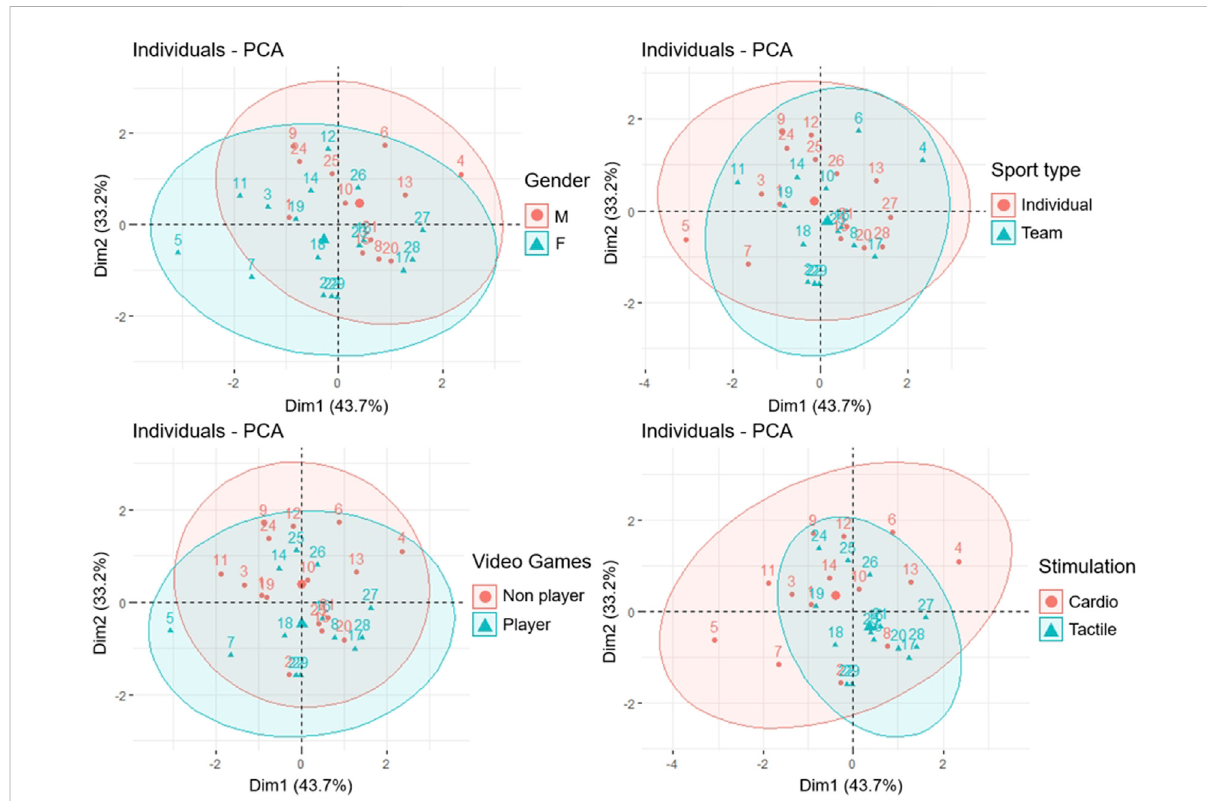
FIGURE 6 95% con fi dence ellipses showing the repartition of participants (numbered) according to distinct individual pro fi les (top-left: gender/top-right: sportstype/bottom-left:videogameshabits/bottom-right:multisensorystimulation).Largelyoverlappedellipsesindicatetheabsenceofdifferences between two sample groups according to a speci fi c variable. Larger dots indicate the baryleft of an